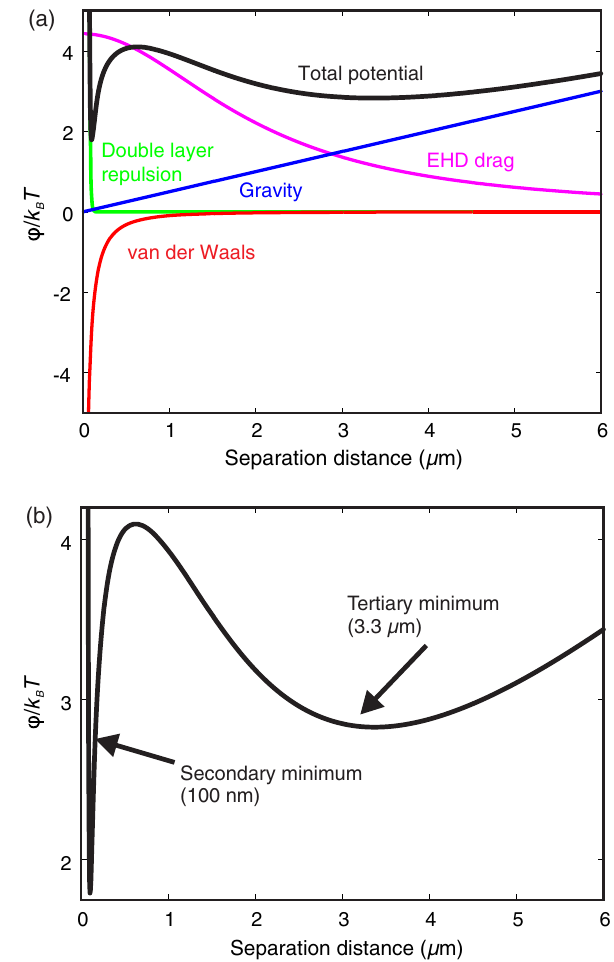
FIG. 5. Particle-electrode interaction potential for a 2 μ m sulfated PS particle in 1 mM NaOH with a 4 Vpp, 100 Hz electric field applied. (a) Interaction potential profiles for each particle-electrode interaction included in the total potential [cf. Eqs. (1) and (2) herein and Eqs. (S1) – (S8) of Ref. [32]). (b) The total interaction potential [Eq. (1)]. Each potential is T scaled to the thermal potential ( k B